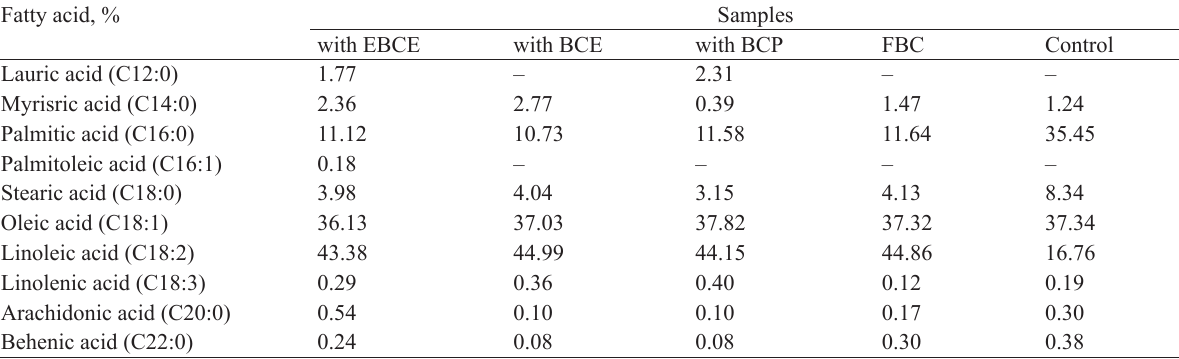
Table 2 Fatty acid composition of kolompeh samples Fatty acid, % Samples with EBCE with BCE with BCP FBC Control